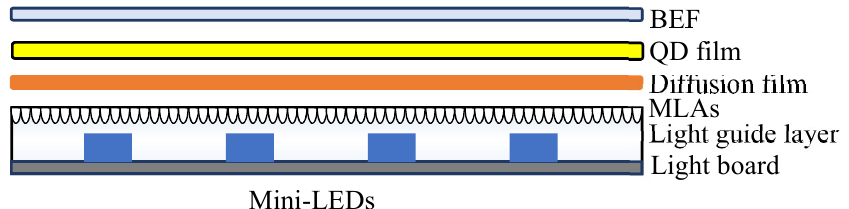
Figure 1. Structure of an extra-thin, large-area, high-luminance surface light source module with microlens arrays (MLAs) combined with a light guide layer. BEF, brightness enhancement film; QD, quantum dot; LED, light-emitting diode.